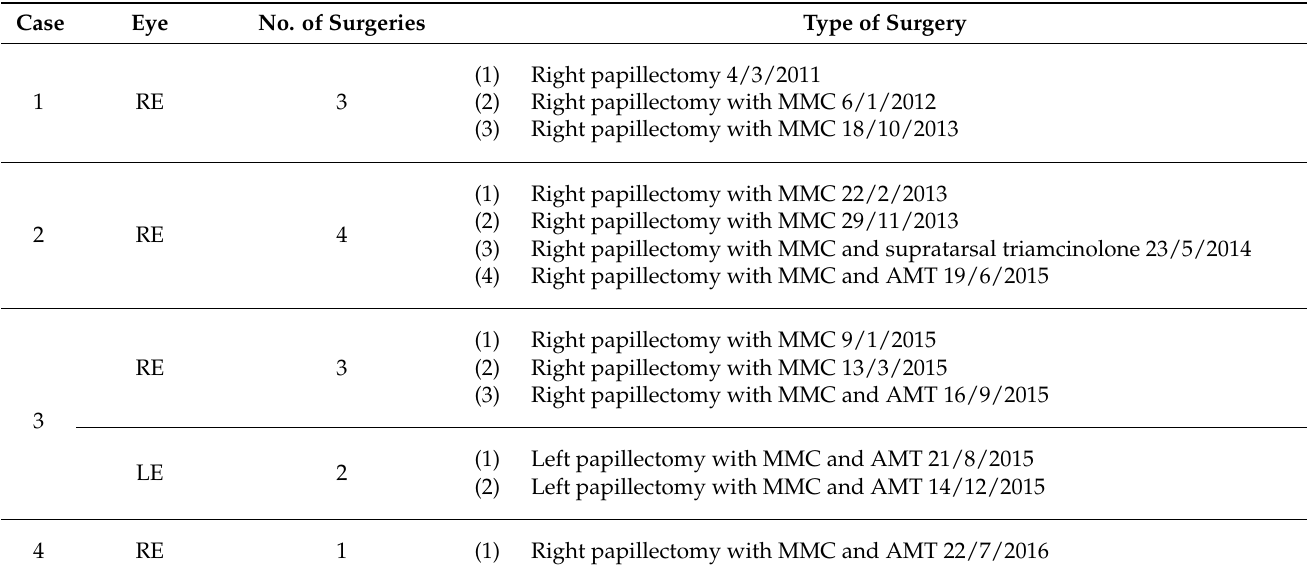
Table 2. Shows type of surgeries performed in all